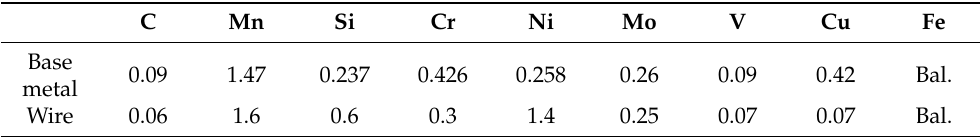
Table 1. Chemical compositions of Q690 plates and the wire (wt%).